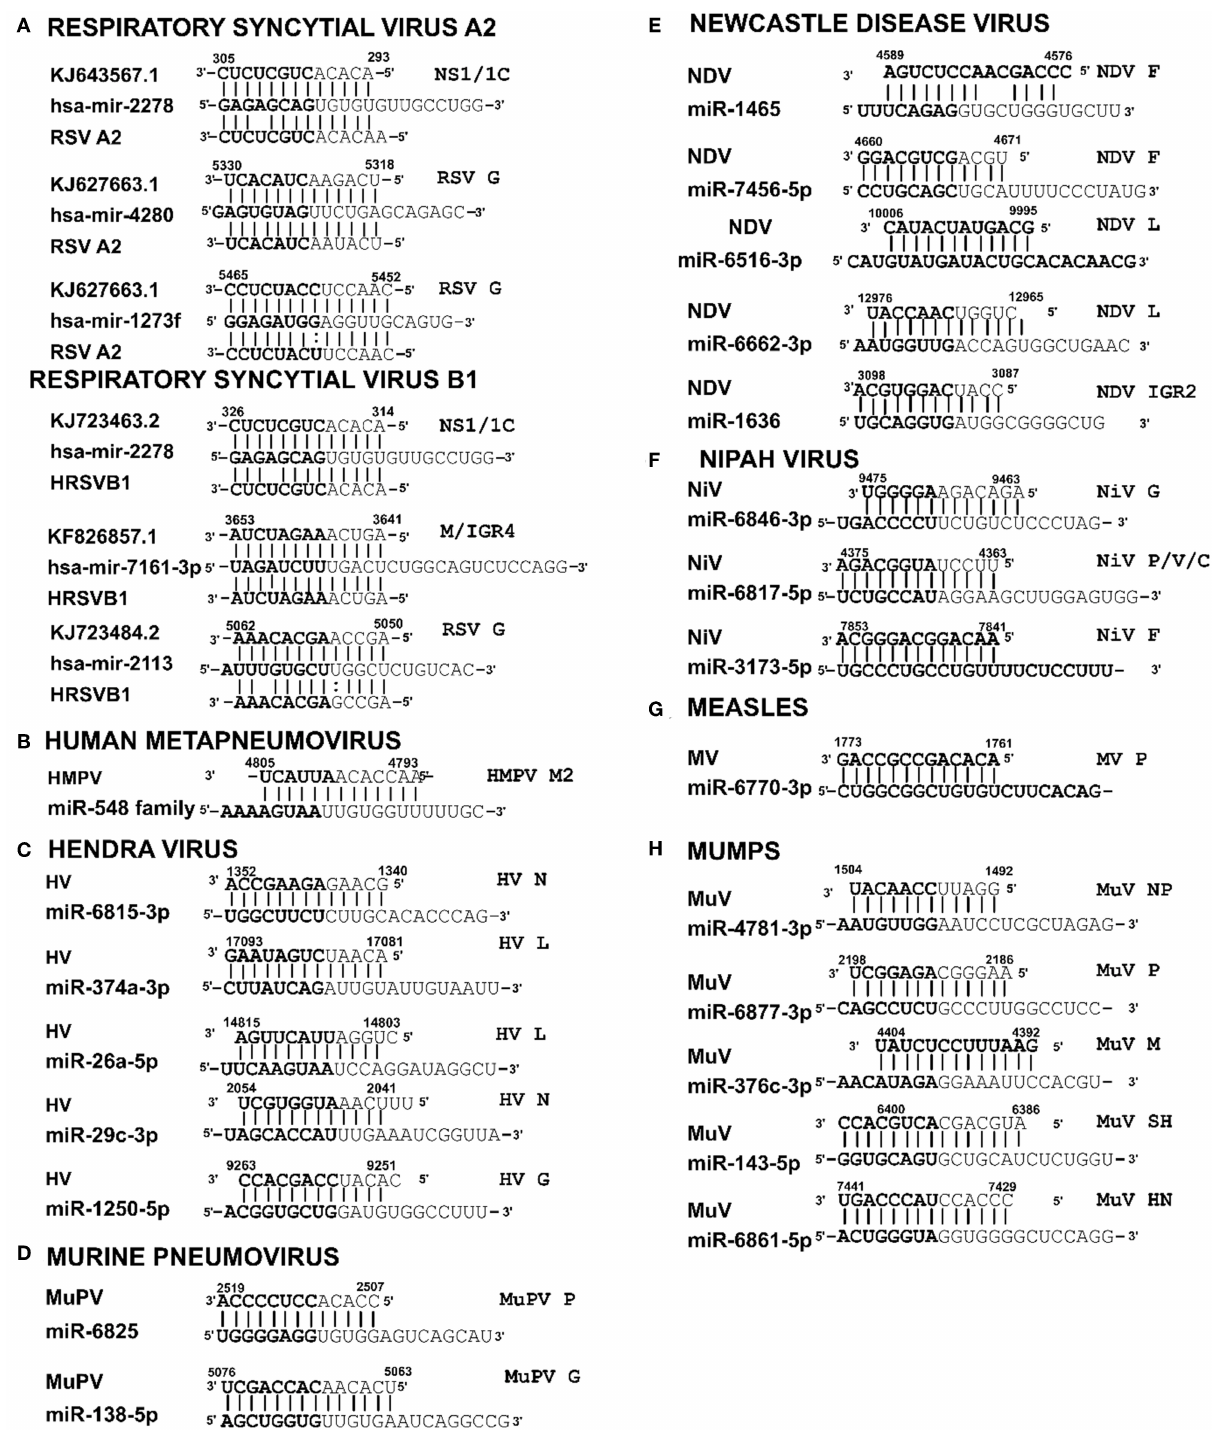
Frontiers in Cellular and Infection Microbiology |